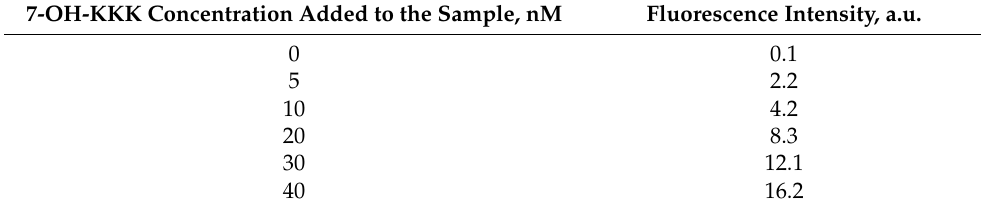
Table 2. Calibration data used to determine the concentration of 7-OH-KKK in aqueous solutions (data from one of the